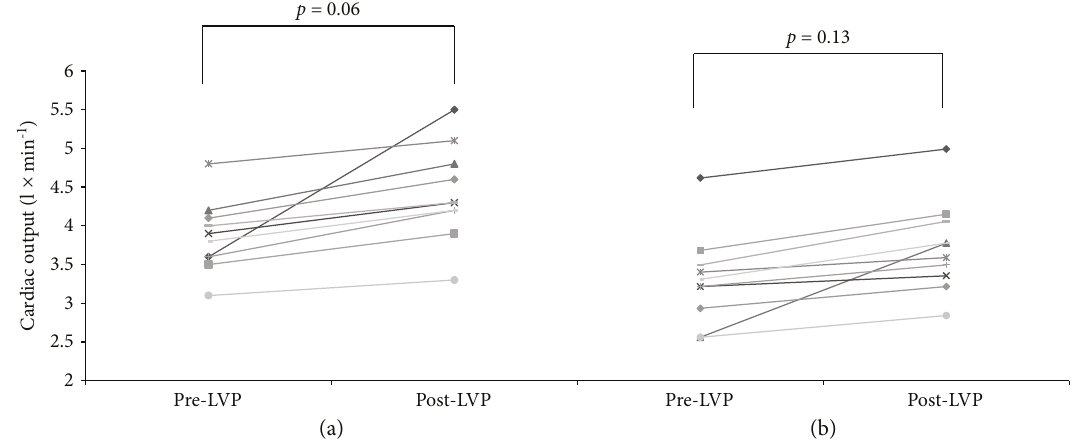
Figure 3: Cardiac output before and after large volume paracentesis: (a) before nonselective β -blocker introduction; (b) after nonselective β -blocker